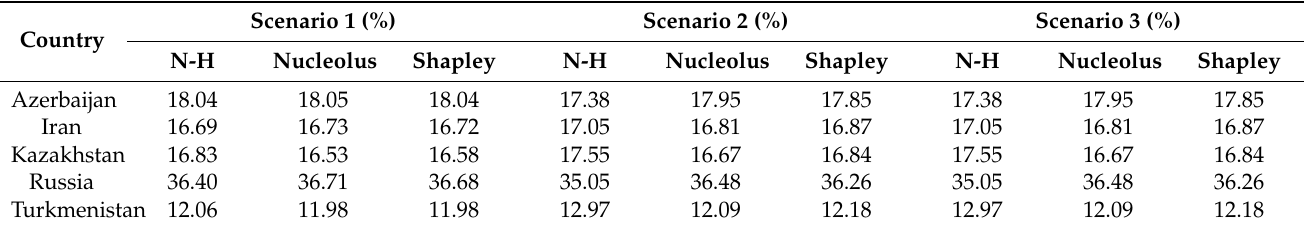
Table 5. Percent of cooperative shares under proposed cooperative game theory methods including bargaining